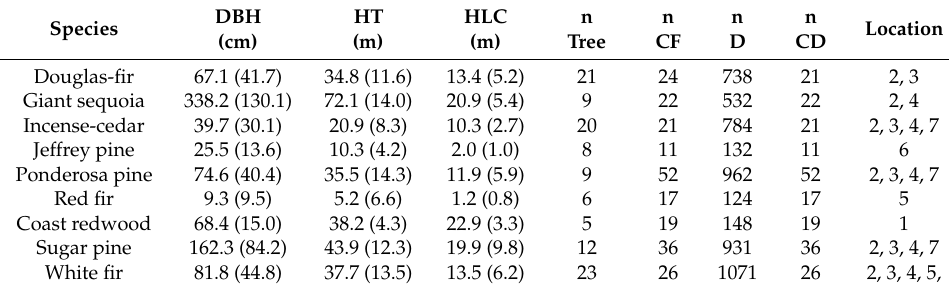
Table 1. Summary statistics for trees used in paired carbon fraction, wood density, and carbon density analyses. Sample sizes for each tree characteristic studied are given. Standard deviations are shown in parenthesis after mean values. DBH: diameter at breast height; HT: total tree height; HLC: height to live crown: CF: carbon fraction; D: density; CD: carbon